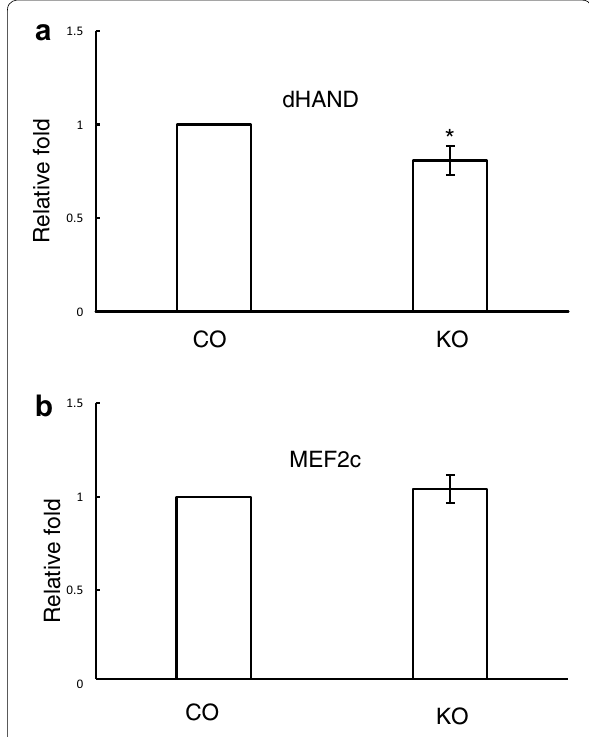
Fig. 2 Microarray analysis of dHand and MEF-2c expression levels in E14.5 embryonic hearts. a The expression level of dHand was down- regulated in the knockout hearts. b MEF-2c expression levels were comparable between control and knockout. *P <